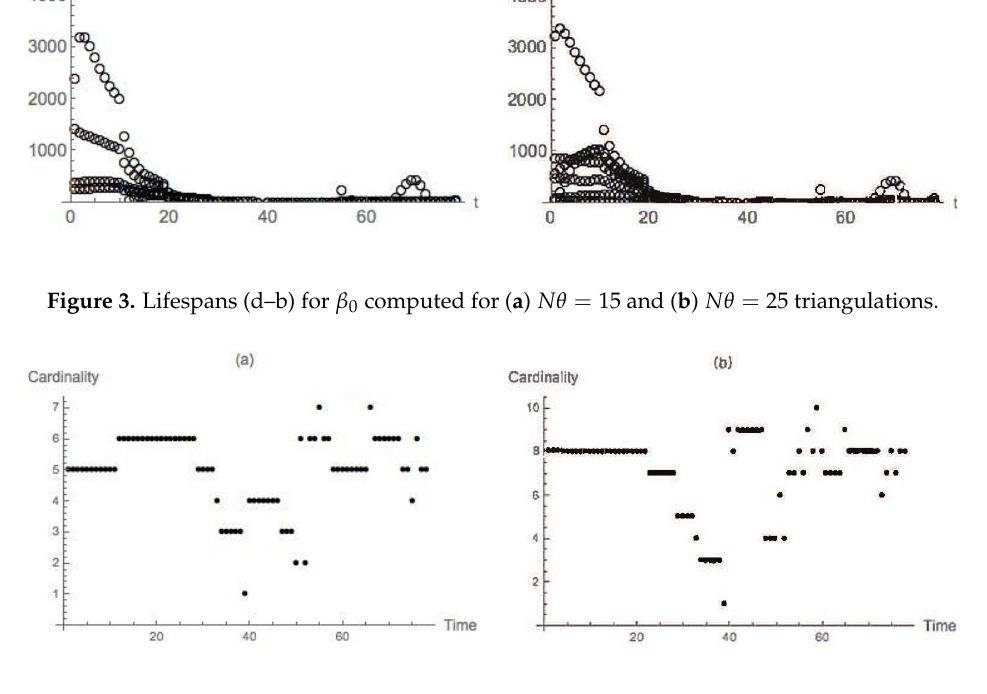
Figure 4. Cardinalities (number of points in PDs) at each time index for β 0 computed for ( a ) N θ = 15 and ( b ) N θ =